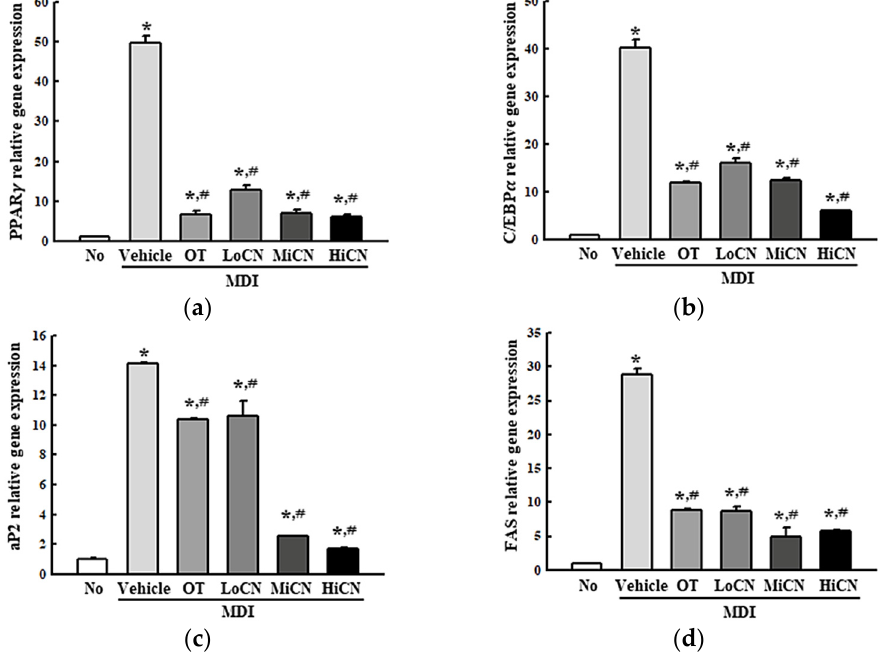
Figure 3. mRNA levels of adipogenic and lipogenic factors. After collecting the total RNA from MDI stimulated 3T3-L1 adipocytes treated with α -cubebenol, the mRNA levels of two adipogenic transcription factors (PPAR γ ( a ) and C/EBP α ( b ) and two lipogenic regulators (aP2 ( c ) and FAS ( d )) were quantified by RT-qPCR, as described in materials and methods. Two to three dishes per group were used to prepare the total RNAs, and qRT-PCR was assayed in duplicate for each sample. The data represent the means ± SD of duplicates. * indicates p < 0.05 compared to the No treated group. # indicates p < 0.05 compared to the MDI + Vehicle treated group. OT, orlistat; MDI, adipogenic cocktail consisting of 3-isobutyl-1-methylxanthine, dexame-thasone, and insulin; LoCN, low concentration (7.5 μ g/mL) of α -cubebenol; MiCN, middle concentration (15 μ g/mL) of α -cubebenol; HiCN, high concentration (30 μ g/mL) of α -cubebenol.